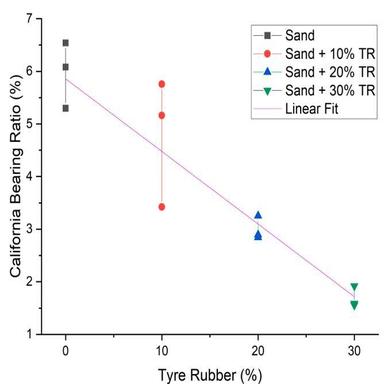
Variation of CBR for the different mixes.